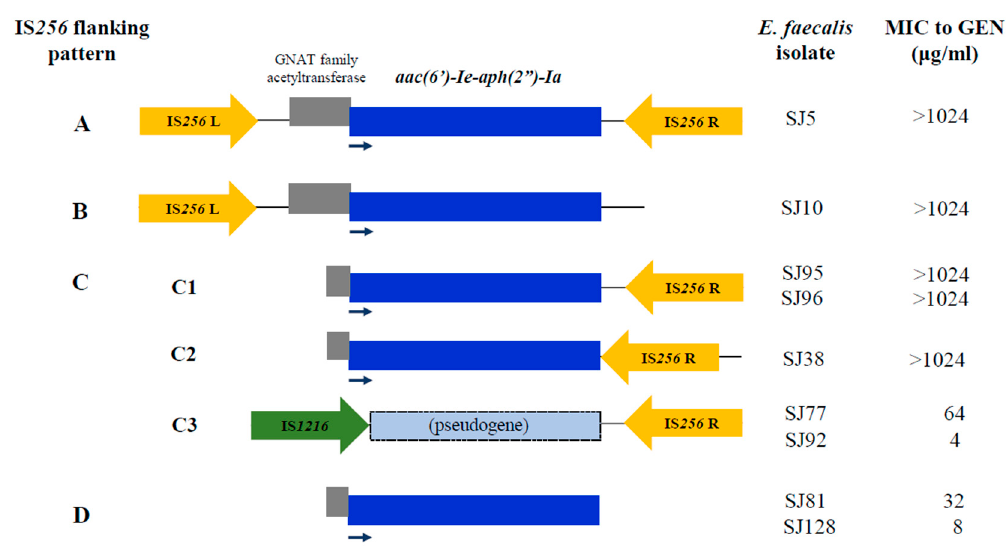
Figure 1. Schematic representation of the IS 256 flanking patterns of aac(6 (cid:48) )-Ie-aph(2”)-Ia (A-D) detected in E. faecalis isolates in the present study. A, Tn 4001 -like structure containing IS 256 (IS 256 -L and -R) at both ends; B-D, Tn 4001 -truncated structure lacking IS 256 at the 3 (cid:48) -end, 5 (cid:48) -end, and both ends, respectively. Intact open reading frame of aac(6 (cid:48) )-Ie-aph(2”)-Ia is shown as a blue box with an arrow indicating the transcription direction. The pseudogene in pattern C3 indicates the incomplete gene that lacks the 5 (cid:48) -end region including the start codon. E. faecalis isolate ID and MIC to GEN are shown on the